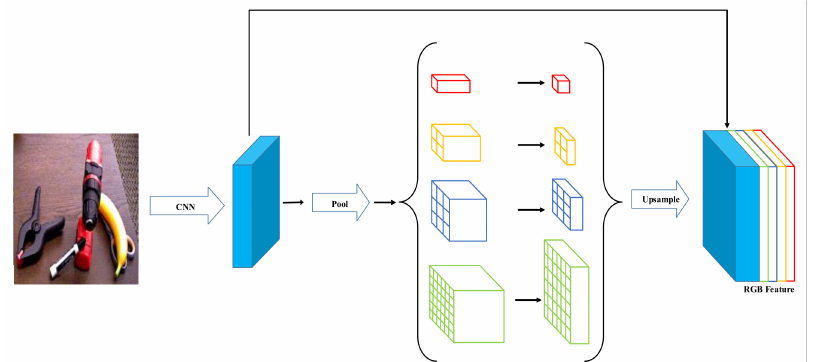
Figure 3. Two-dimensional feature extraction based on PSPNet, which integrates four features of different pyramid scales, and then, these features are upsampled to obtain feature maps, which are finally concatenate with the original feature map.